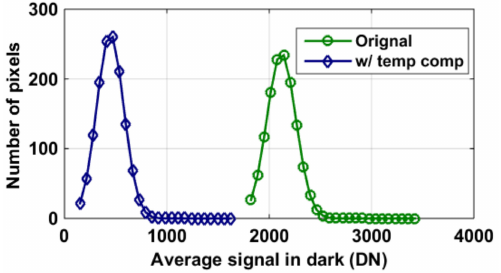
Figure 18. Histogram of measured dark signal and dark signal non-uniformity (DSNU). Original: measured at 60 ◦ C and 250 ms, averaged 100 frames; w/ temp comp: compensation by subtracting the reference dark current at room temperature, along with predicted dark current using temperature information (as shown in Figure